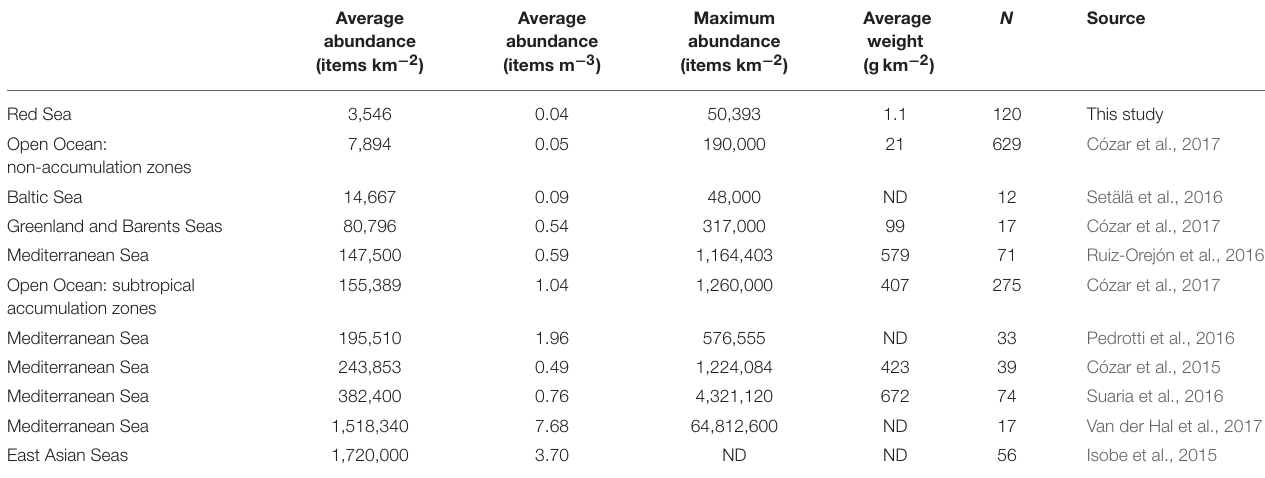
TABLE 1 | Comparison of floating plastic fragment concentrations (listed by increasing number) obtained in previous studies performed in the open ocean and other semi-closed seas and those derived here for the Red